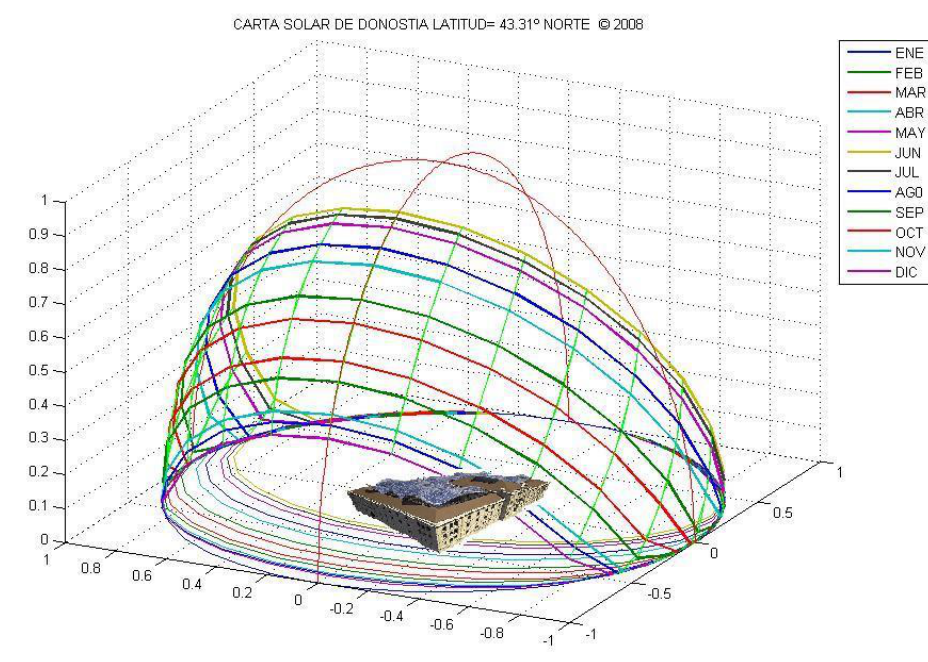
Figure 15. Solar chart for the new cultural centre.